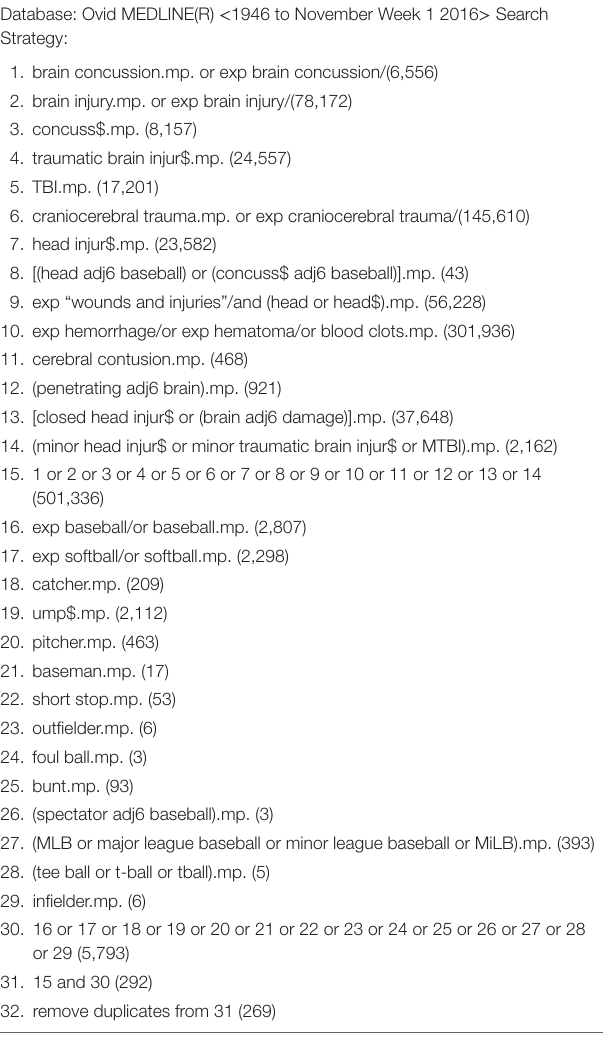
taBLe 1 | Search results from Ovid